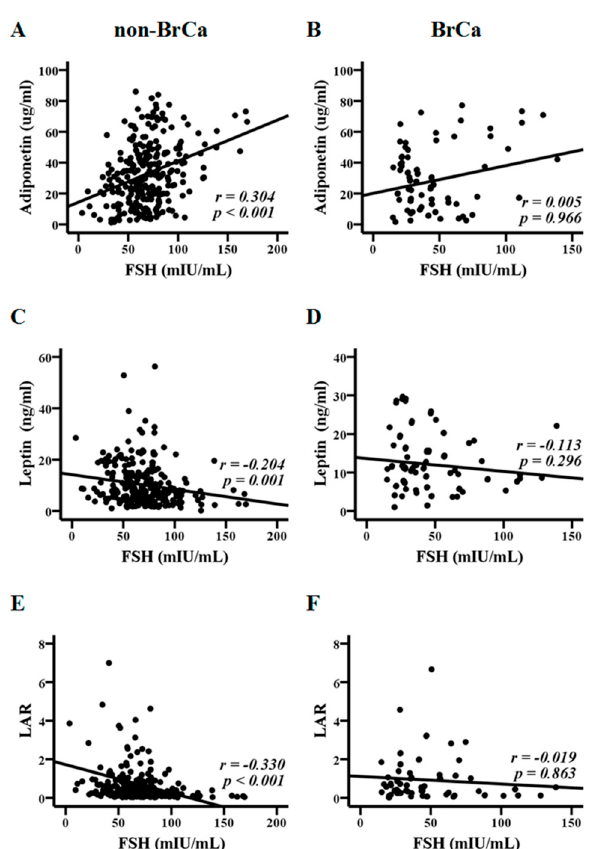
Figure 2. Associations between FSH, adiponectin, leptin, and the leptin to adiponectin ratio (LAR). FSH was correlated with adiponectin ( A ), leptin ( C ), and the LAR ( E ) in the non-breast cancer (non-BrCa) group, but not with adiponectin ( B ), leptin ( D ), and the LAR ( F ) in the breast cancer (BrCa) group. Statistical analysis was conducted by Spearman’s rank test.